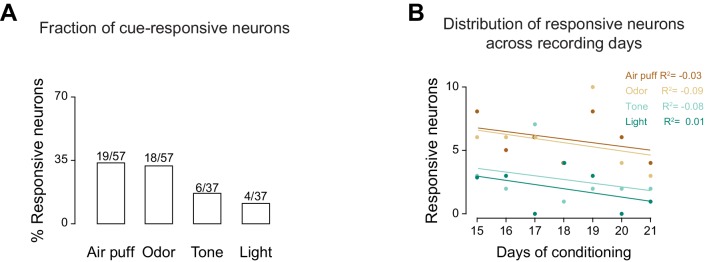
The neural bias for somatosensory and olfactory stimuli does not depend on the number of sessions at final performance level.(A) Percentage of GC neurons modulated by cross-modal stimuli after matching the number of recording session at final performance level. (B) Distribution of the number of cross-modal neurons across recording days following reaching final performance level. Each full circle represents the number of responsive neurons recorded for each experimental day. Different colors represent responses to different cross-modal stimuli (see legend). Straight lines represent the best linear fit through each point.